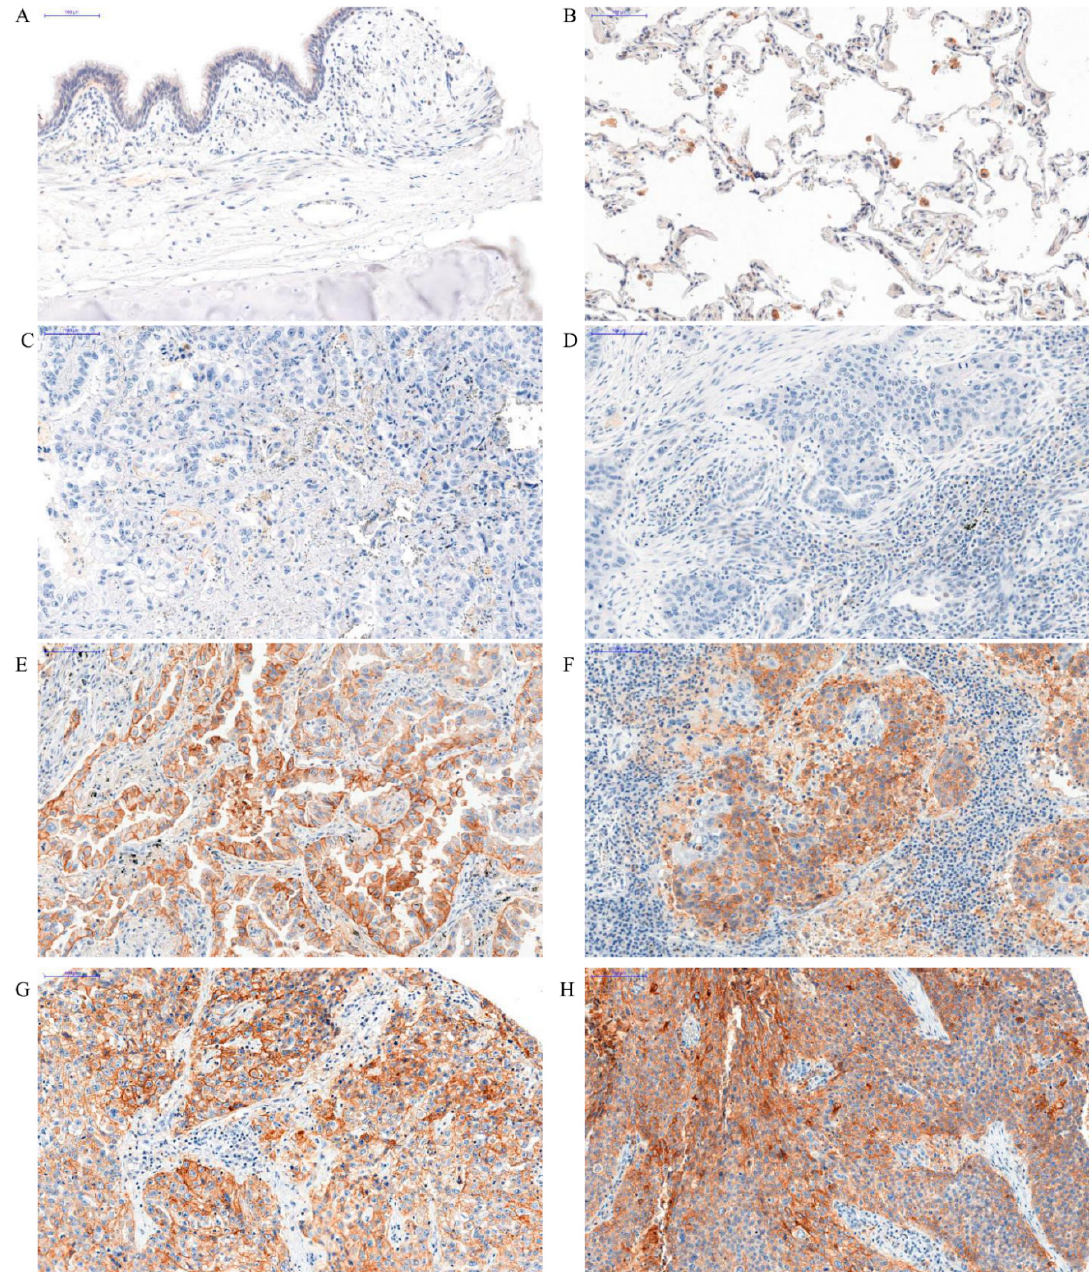
Figure 1. Positive membranous immunohistochemical reaction (brown) indicating PD-L1 expression performed on healthy lung tissue ( A and B ) and in different grades of malignancy in adenocarcinoma (AC) ( C , E , G ) and squamous cell cancer (SCC) ( D , F , H ). Lack of PD-L1 expression—healthy lung tissue ( A ) and PD-L1 expression in macrophages—positive control ( B ). Expression of PD-L1 increased in higher malignancy grade in AC—G1 ( C ), G2 ( E ), and G3 ( G ), and in SCC—G1 ( D ), G2 ( F ) and G3 ( H ), magnification, ×200.